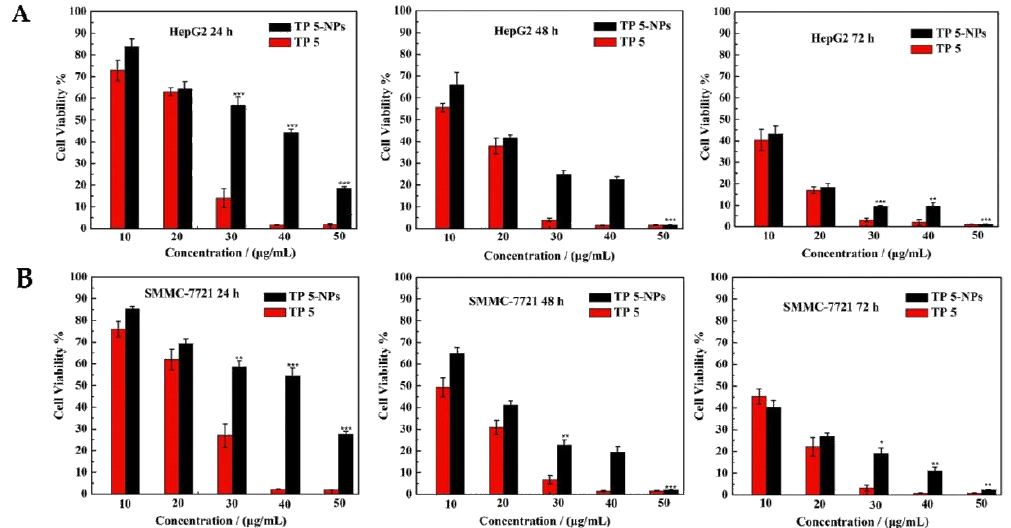
Figure 6. Cytotoxicity of free TP 5 and TP 5 -NPs. HepG2 ( A ) and SMMC-7721 ( B ) cells were treated by TP 5 or TP 5 -NPs for 24, 48 and 72 h. Data are displayed as mean ± SD (n = 6). * p < 0.05, ** p < 0.01, *** p < 0.001, TP 5 -NPs vs. TP 5 . Both free TP 5 and TP 5 -NPs exhibited dose and time-dependent cytotoxicity. The cells were completely killed when the concentration of free TP 5 exceeds 40.0 μg/mL. Abbreviations: TP 5 ; thiophene derivatives; TP 5 -NPs, TP 5 -loaded nanoparticles.